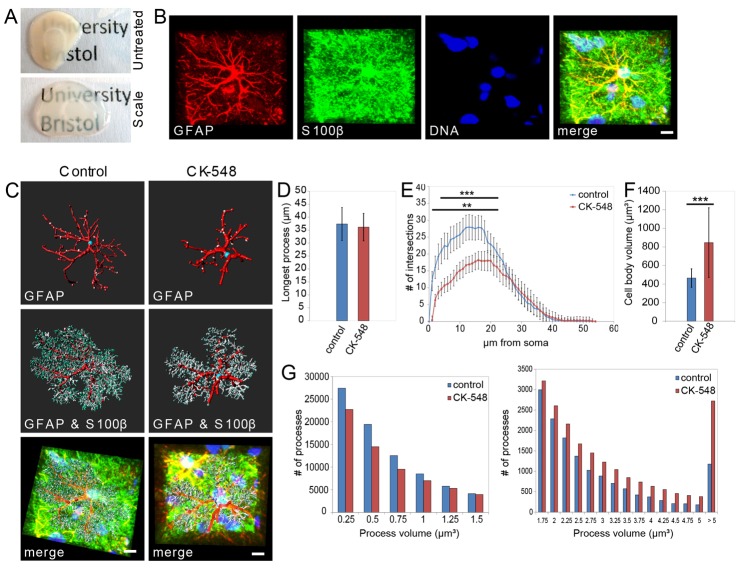
Acute inhibition of the Arp2/3 complex in astrocytes in brain slices. (A) Demonstration of a modified tissue clearance procedure, allowing deep-tissue antibody staining and imaging by confocal microscopy. Untreated cortical slice (top) in comparison to cleared tissue (bottom). (B) Z-projection of a control astrocyte 40 µm within the cortical slice, previously stained for DNA (Hoechst 33258), GFAP and S100β, as acquired by confocal microscopy after tissue clearance. Scale bars: 10 µm. (C) Filament tracing of GFAP- and S100β-positive processes in an individual astrocyte. Main processes were defined by GFAP immunoreactivity (top). Fine structures were determined by S100β immunoreactivity (center). Overlay of 3D models and confocal z-projections (bottom). Left panels: control astrocyte. Right panels: astrocyte from a slice treated with CK-548. Scale bars: 10 µm. (D) Quantification of longest processes in control and CK-548-treated astrocytes, based on GFAP immunoreactivity. n = 20 per condition, P>0.05 (unpaired Student's t-test). (E) Sholl analyzes on combined GFAP- and S100β-positive processes in control (blue) and CK-548-treated (red) astrocytes. n = 20 per condition, **P<0.005, ***P<0.0005 (unpaired Student's t-test and Sidak–Bonferroni method). (F) Quantification of soma volumes from control and CK-548-treated astrocytes. n = 20 per condition, ***P<0.0005 (unpaired Student's t-test). (G) Frequency of individual S100β-positive process volumes from control and CK-548-treated astrocytes. (90,000 S100β-positive processes from 20 cells per condition). Left graph: small processes up to 1.25 µm3. Right graph: larger processes greater than 1.5 µm3.